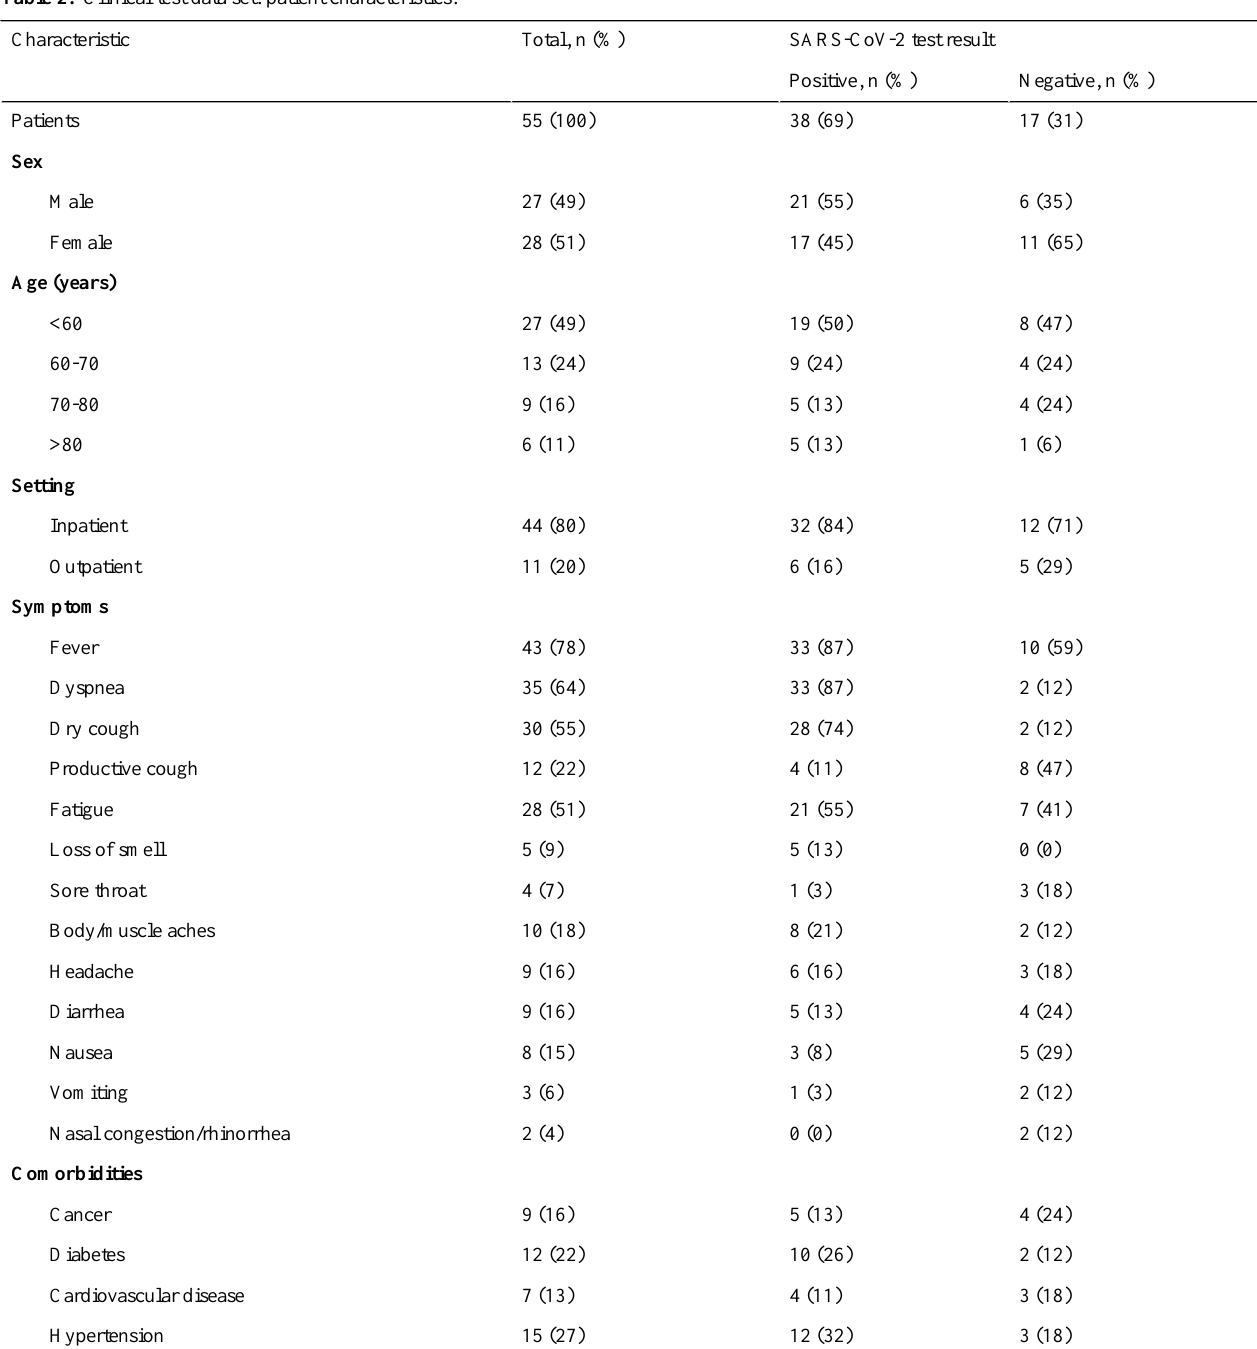
Table 2. Clinical test data set: patient